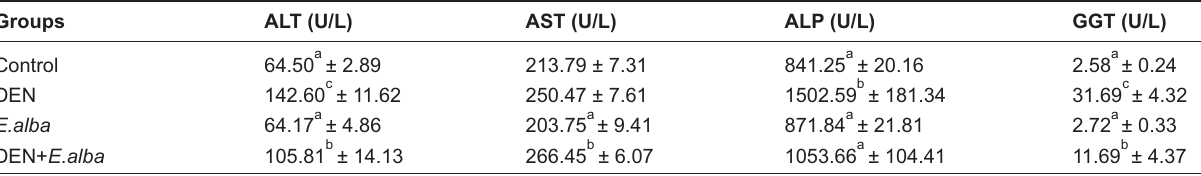
on serum ALT, AST, ALP and GGT of control and treated animals (mean±SE). E. alba